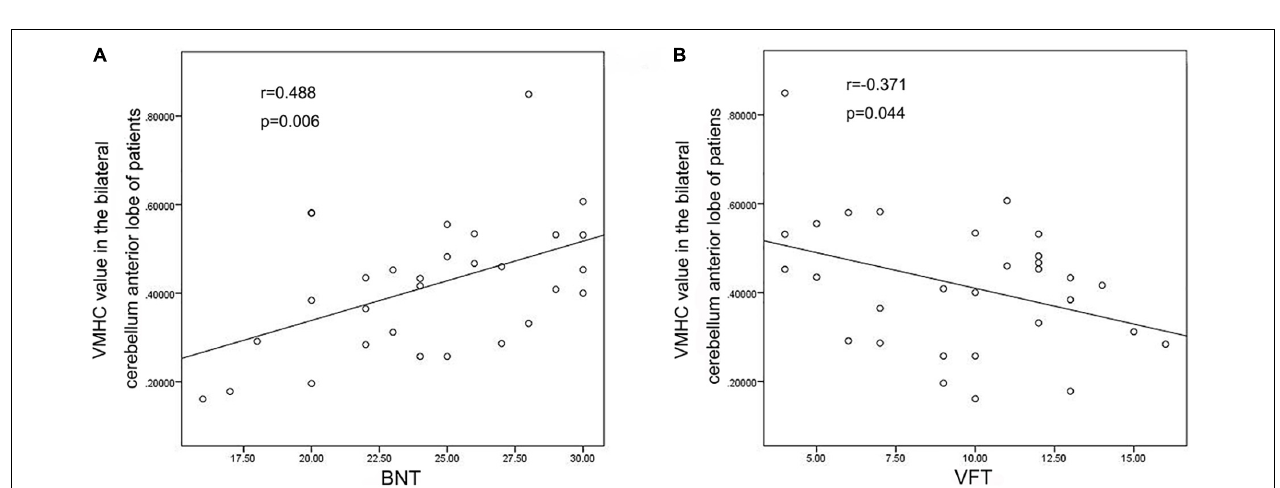
FIGURE 1 | The altered cerebellum and brain regions were revealed in the VMHC analysis. Cold tones shows decreased VMHC.